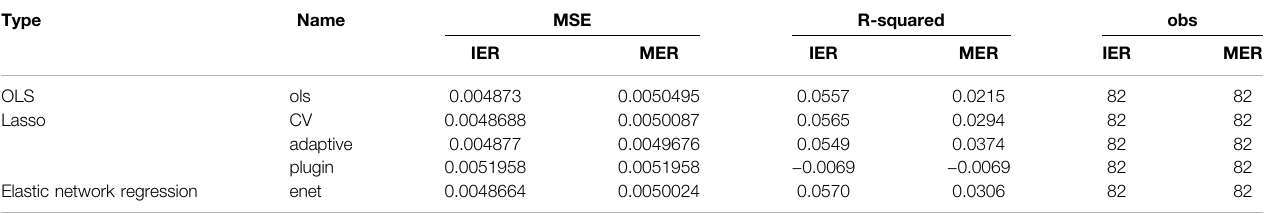
TABLE 3 | MSE of different methods.